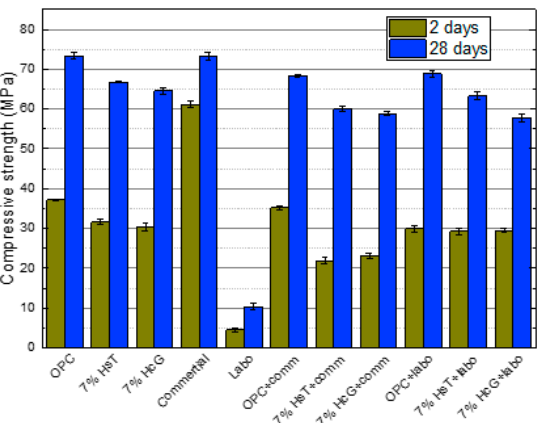
Figure 5. Compressive strength obtained at 2 and 28 days for all the eco-cements.